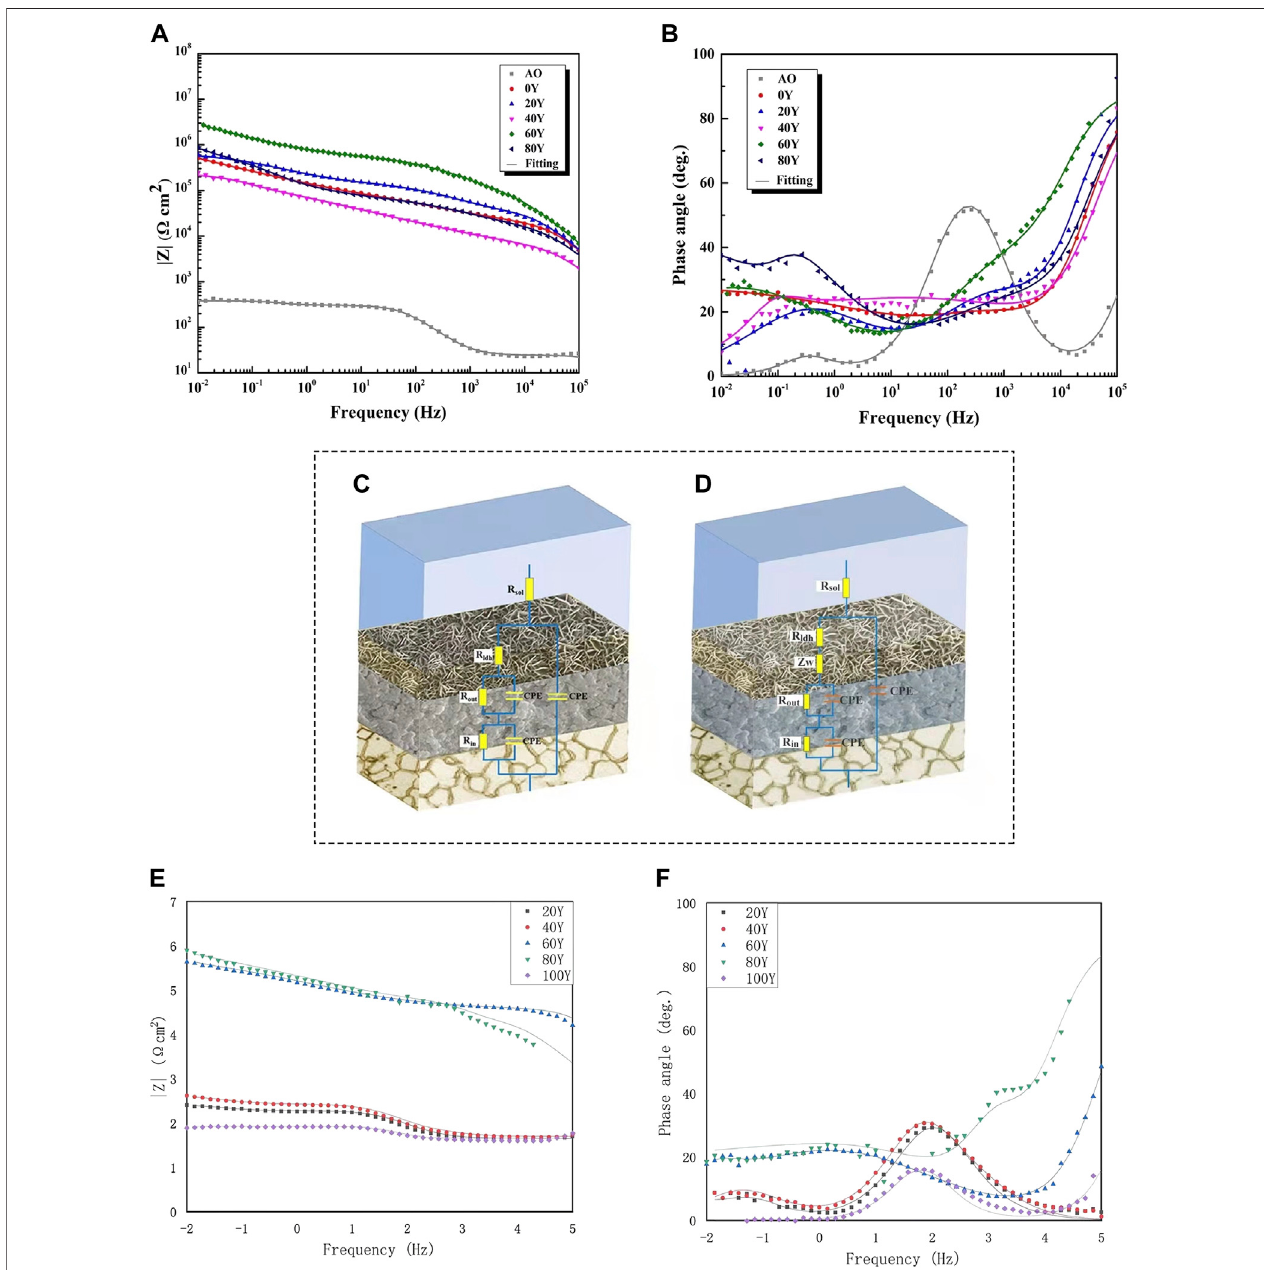
FIGURE 7 | EIS spectra of specimens immersed in 3.5 wt% NaCl solution. (A,B) ; equivalent circuits and physical models of coatings (C,D) ; EIS data and fi tting curves (straight line) of different coatings in 3.5 wt% NaCl solution after immersion for (E,F) 4 days.